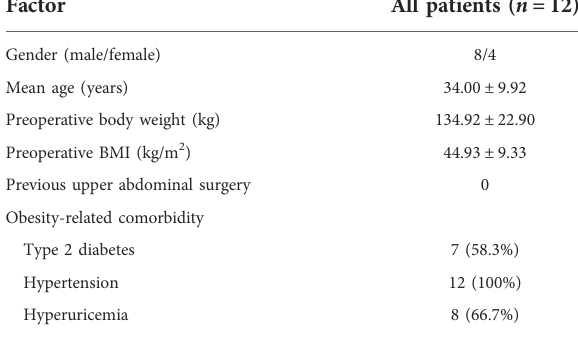
TABLE 1 Patient